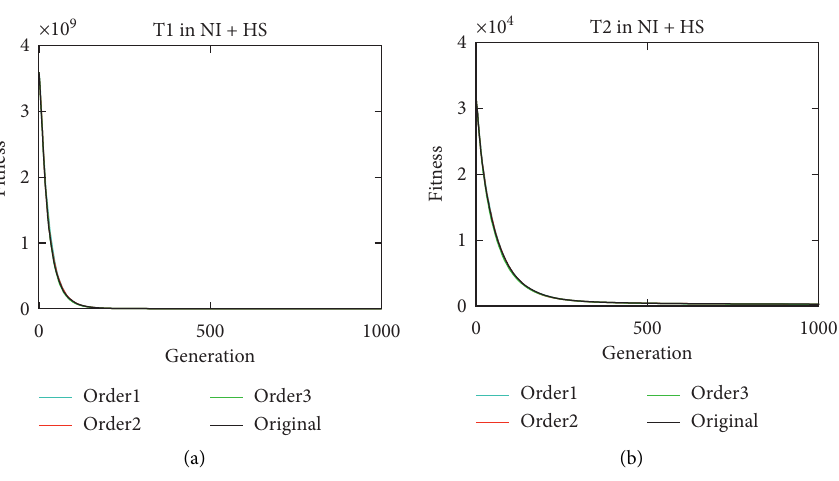
Figure 10: Convergence of MFEA for problem 7 (NI+HS).